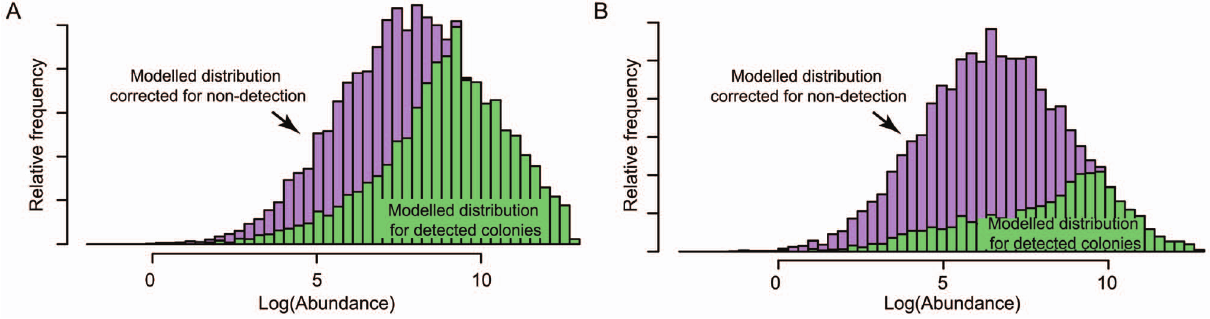
Figure 3. Colony size distribution censored by Landsat-7 detection limit. We used a log-normal distribution model for colony size to calculate the total abundance of Ade´lie penguins not captured by our Landsat survey (see Eq. 2). The influence of size-dependent non-detection on the distribution of colony sizes detected by Landsat in continental Antarctica (A) and on the Antarctic Peninsula (B) can be seen in the difference between the modelled distribution of colony sizes (log-scale) for all Ade´lie penguin colonies (purple) and the distribution of colony sizes as detected by Landsat (green).